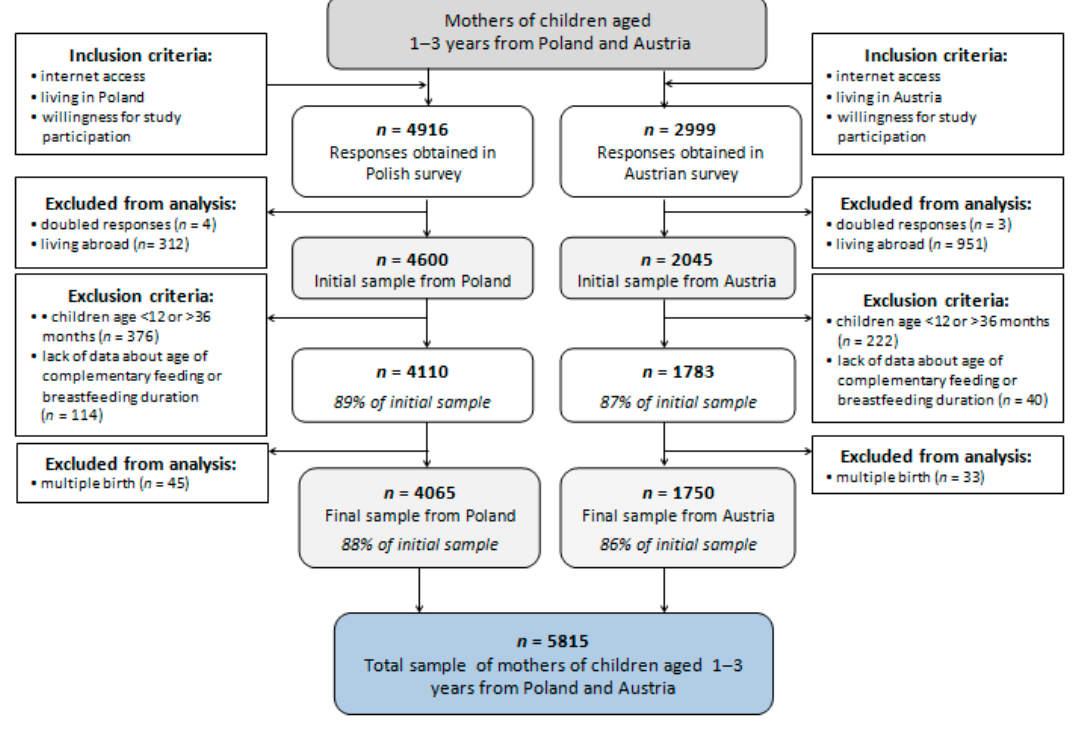
Figure 1. Study sample collection flowchart.